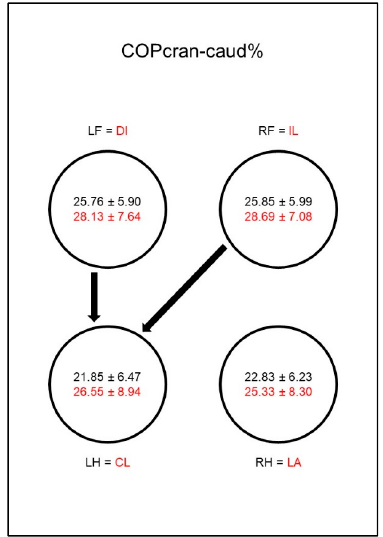
Figure 7. Cranio-caudal displacement of the center of pressure as a percentage of maximum length of paw contact area (COPcran-caud%) in study group 1 and control group. For detailed explanation and abbreviations refer to Figure 2.